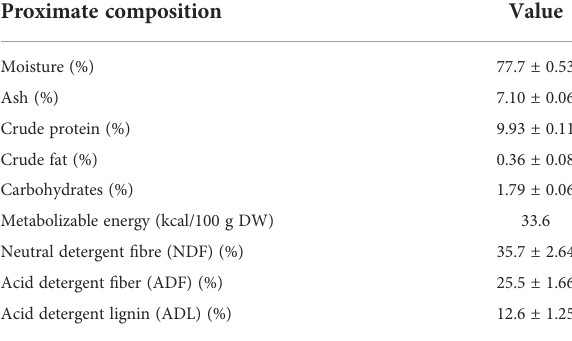
TABLE 1 Nutritional pro fi le of leaves of Limonium spathulatum .